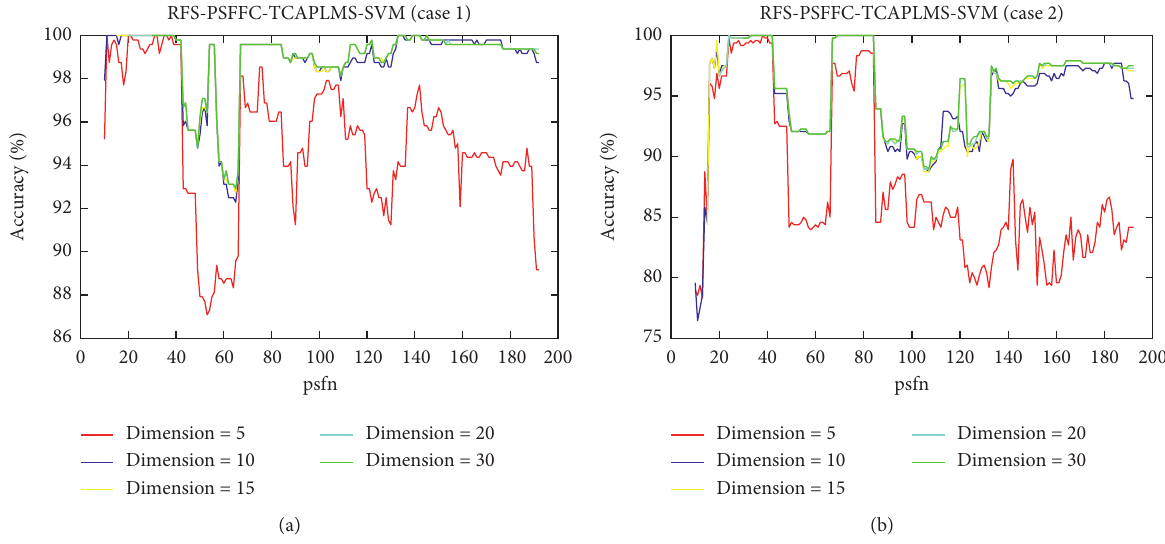
Figure 20: The testing accuracies of RFS-PSFFC-TCAPLMS-SVM with different dimension sizes for TCAPLMS.